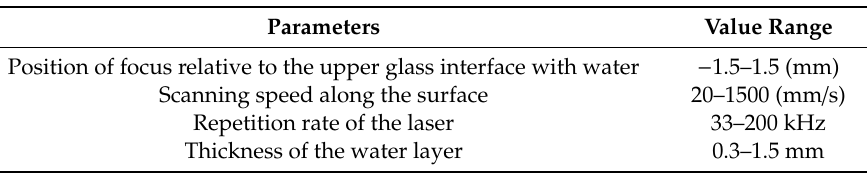
Table 1. Parameters varied during femtosecond laser micromachining experiments. The average power was kept constant at 10 W.